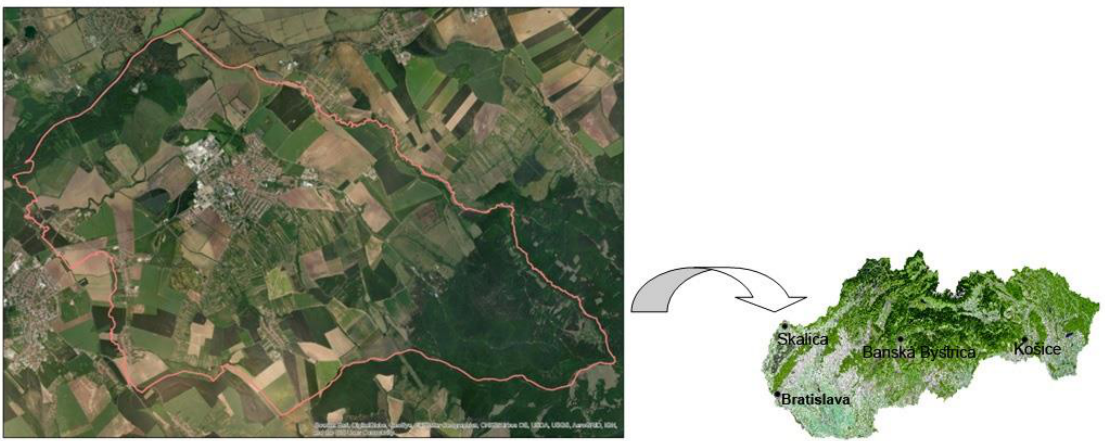
Figure 1. Model area of the Skalica municipality.